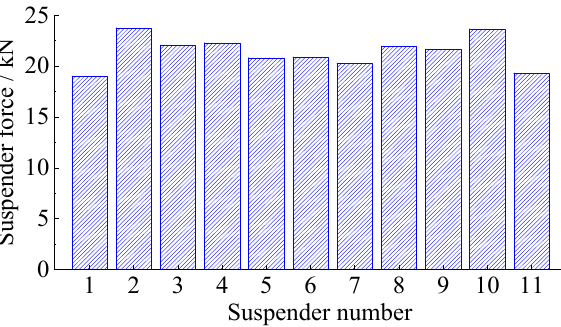
Figure 8. The suspender forces of different suspenders under constant loading.